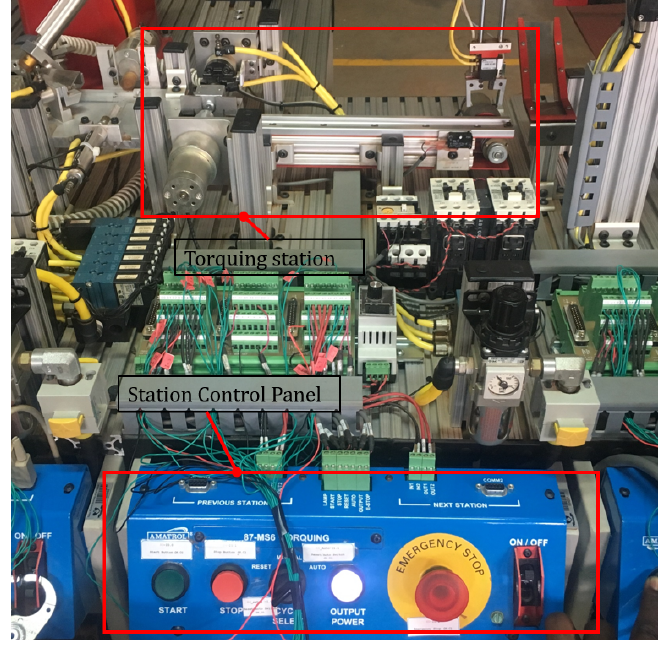
Figure 5. The physical set-up of the torquing